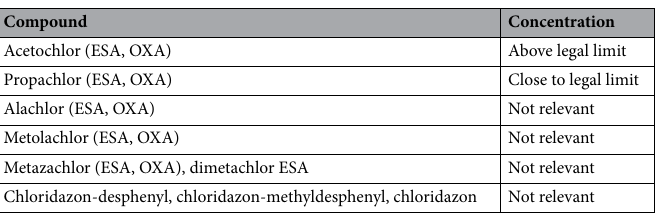
Table 6. Pesticide compounds detected in the treated waters. ESA ethanasulfonic acid metabolites, OXA oxanilic acid metabolites.